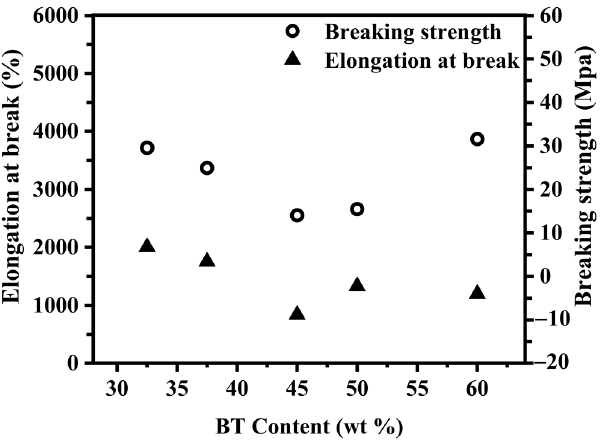
Figure 4. The elongation at break and breaking strength of PBST copolymers with different BT contents.